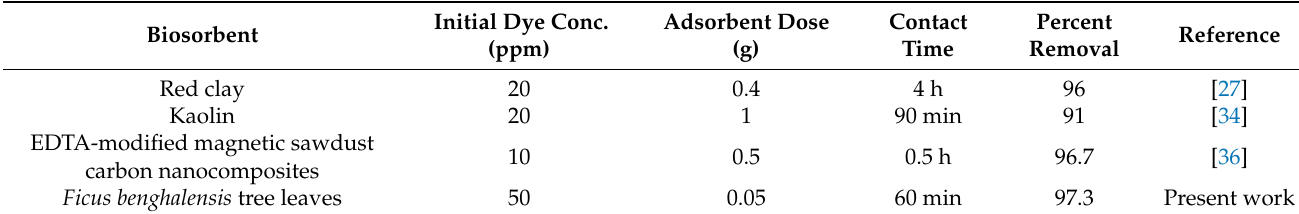
Table 1. Comparative analysis of different adsorbents for brilliant green removal.